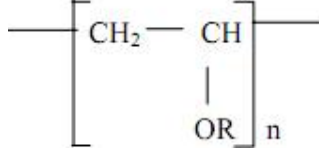
Figure 3. Structure of polyvinyl